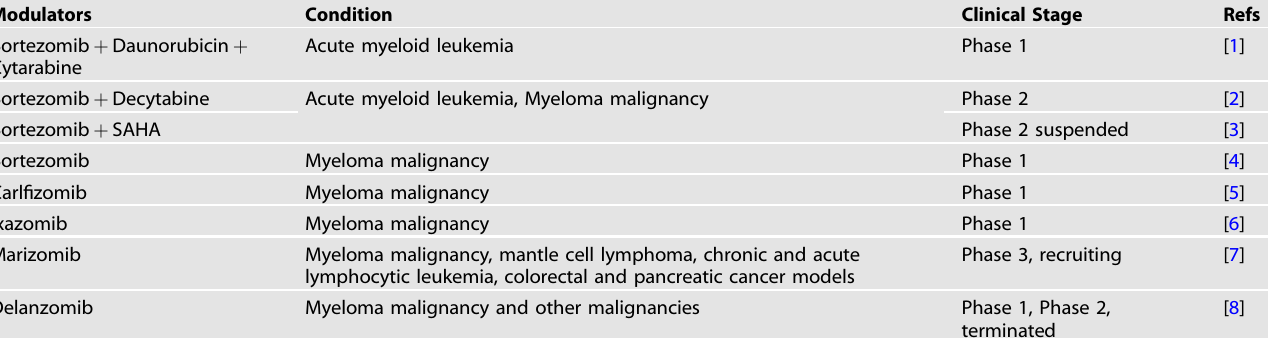
Table 3. Proteasome small molecule inhibitor of B5 protease for cancer